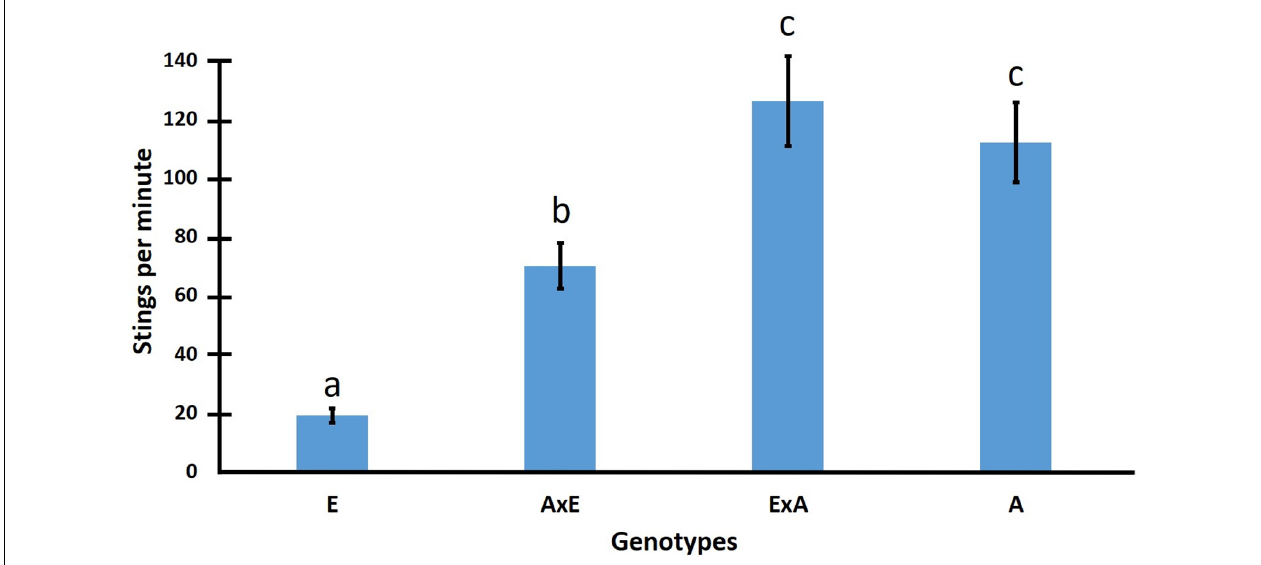
FIGURE 5 | Mean number of stings per minute on leather patches from four years of testing for colonies of four honey bee genotypes: E (European), AxE (F1 of European paternity) ExA (F1 of Africanized paternity), A (Africanized) (data from Guzman-Novoa et al.,